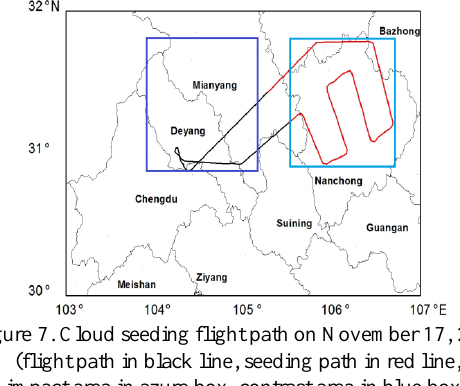
Figure 7. Cloud seeding flight path on November 17, 2018 (flight path in black line, seeding path in red line, impact area in azure box, contrast area in blue box) 3.2.2 Cloud Seeding Effect ： Figure 8 and figure 9 are RGB image and T-Re profiles respectively at 11:30 LST. Most areas of Sichuan Basin are covered by clouds mainly in yellow, light red, purple and green color. Region 3 is yellow, light red and green cloud area. The cloud top temperature is higher between 0 ℃ and -7 ℃ , and the particle effective radius is smaller, less than 10 micron, indicating that this area is covered by low clouds with mainly liquid particles. Region 1 is a purple-red cloud area. In this region, cloud top temperature ranges from - 10 ℃ to -19 ℃ , the particle effective radius ranges from 15 micron to 35 micron and up to 40 micron. Thus, this region is a cold cloud region with larger cloud droplets or sufficient ice crystals, which can effectively start the process of collision, growth and ice transformation. Rainfall has been detected by ground automatic stations in region 1. The average hourly rainfall exceeds 1 mm, indicating that there is a good correspondence between region 1 and rainfall. Region 2 is yellow and light-red cloud area. The cloud top temperature is